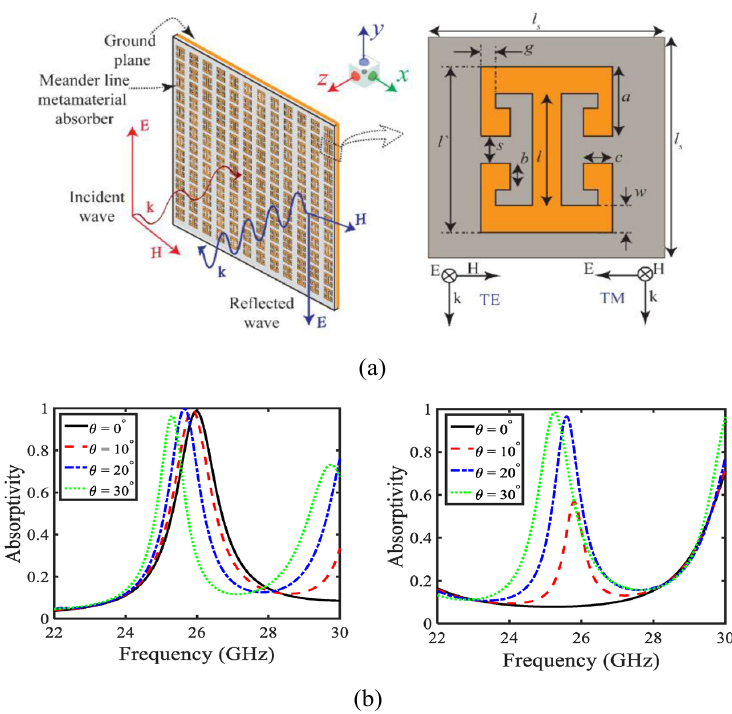
Figure 16. Dual-band absorber with geometry snapshot and absorption percentage plot ( a ) geometrical configuration ( b ) absorption results. Reprinted from Ref [170].